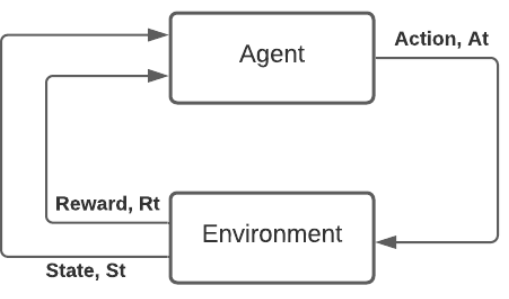
Figure 3. Agent–environment interaction in a Markov decision process.